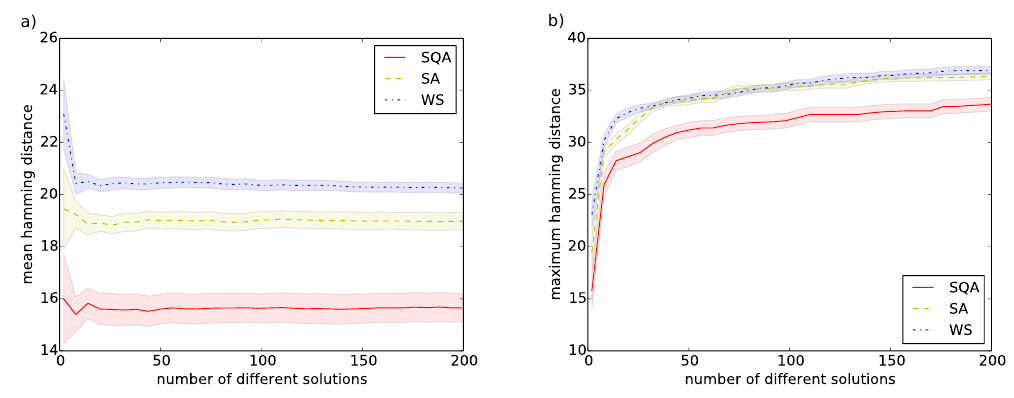
Figure 4: Pairwise Hamming distance between different solutions randomly picked from the solutions obtained by each solver within 2000 runs. The Hamming distance was calculated for up to 200 different solutions found for each of 20 randomly generated 4-SAT instances with ≈ 8.06. An average was taken over the n = 50 variables and a clauses-to-variables-ratio of α χ 4 instances. a) Shows the average pairwise Hamming distance between the picked solutions. b) Shows the maximum pairwise Hamming distance between the picked solutions.